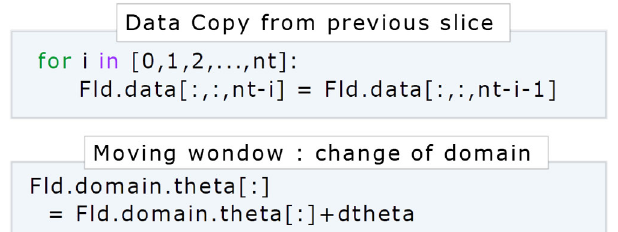
FIG. 7. Pseudocode illustrating slippage implementation of the copying data and the moving window. The first two indices of the field data represented by Fld.data are for the transverse mesh points while the last index is for the temporal mesh point. Here, nt is the number of temporal mesh points. The domain range represented by Fld.domain is used by deposition and inter- polation algorithm. Therefore, change of the domain range by dtheta effectively slip the field by dtheta